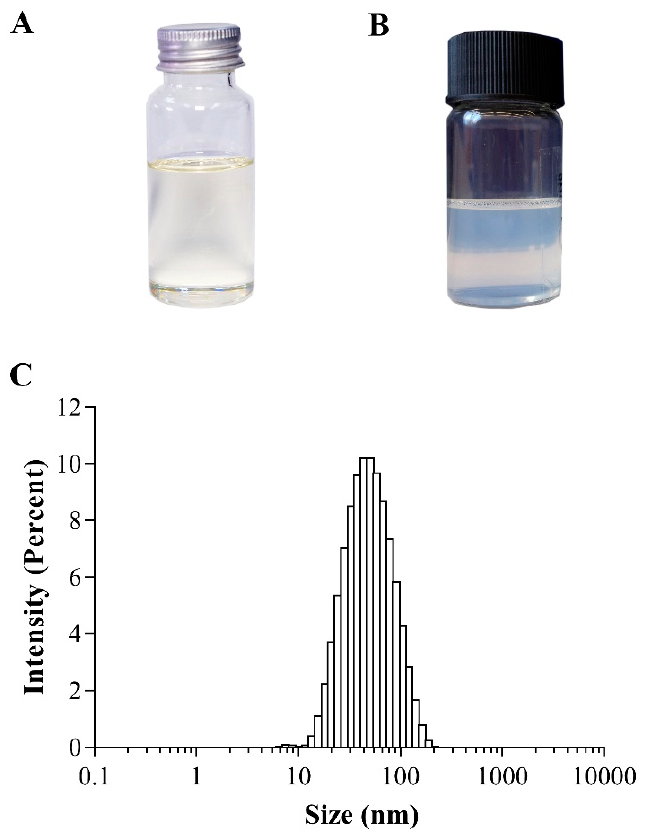
Figure 2. The outer appearance of ( A ) AGO and ( B ) NE-AGO, and ( C ) size distributions of NE- AGO.